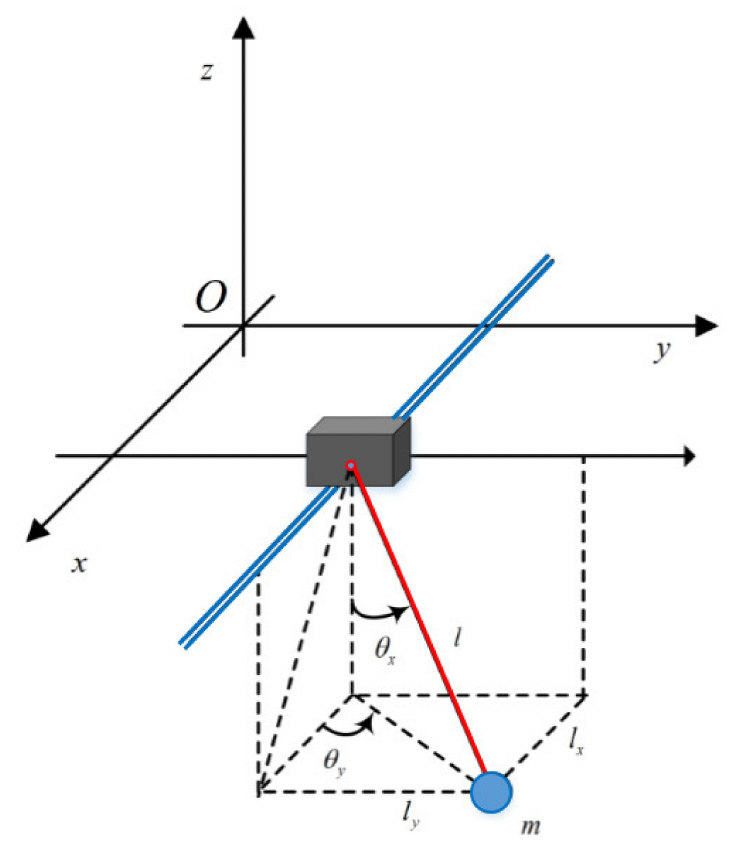
Figure 1. The physical model of a 3-dimensional overhead